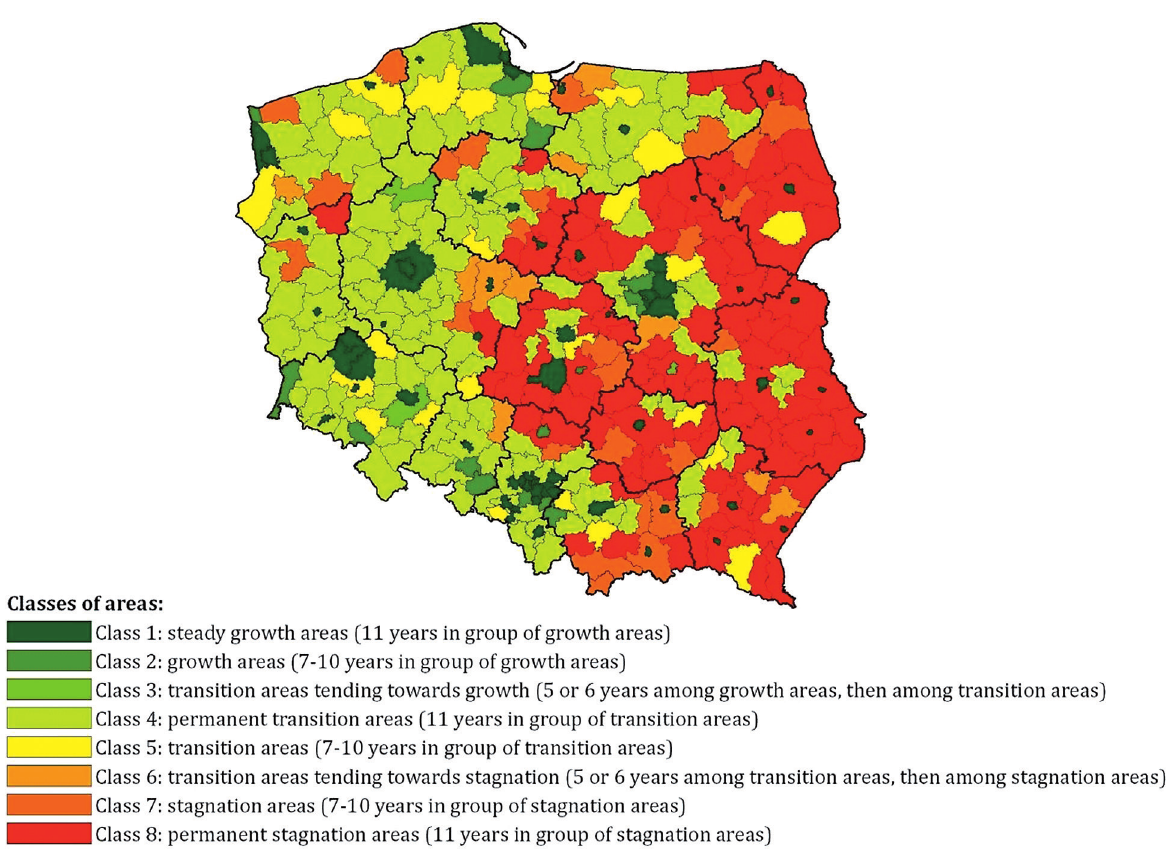
Fig. 6. Spatial distribution of classes of growth and stagnation areas by NUTS 4 units: a general approach Source: own